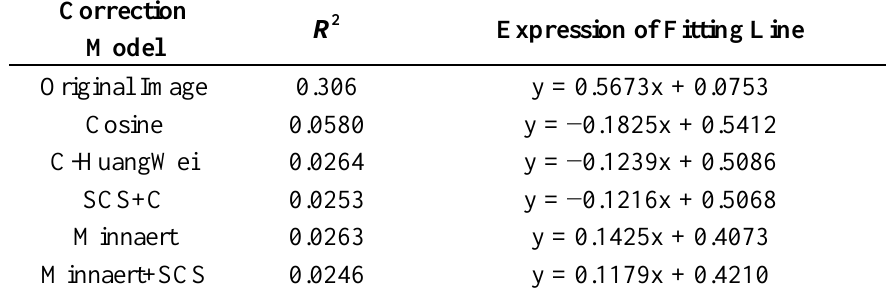
Table 6. R 2 and the linear regression fitting expressions of reflectance band 4 and cosi before and after